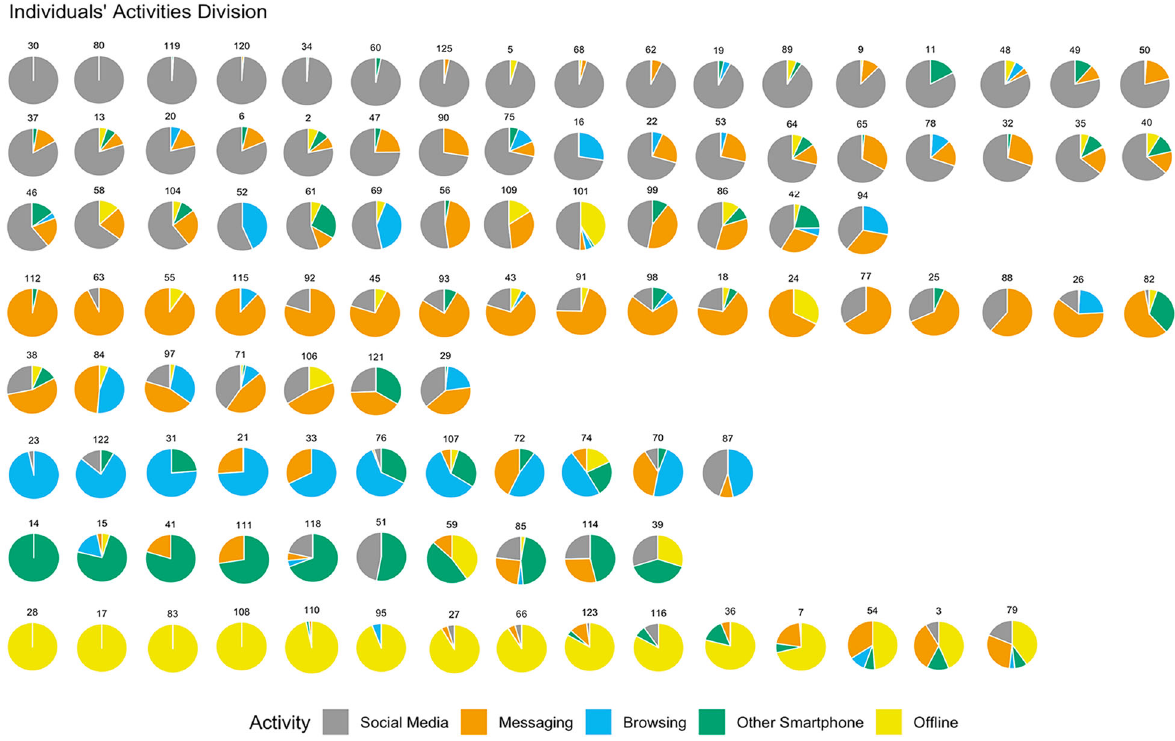
Fig. 2 Individuals ’ activities division. Individual participants ’ activity pie charts. While we tested 125 participants, we present data on 114 of these participants. Participants for whom we did not have data ( n = 11), either because of technical dif fi culties, or because the stimulated recall interview did not take place, are not included in this fi gure. Participant IDs reported above the individual pie